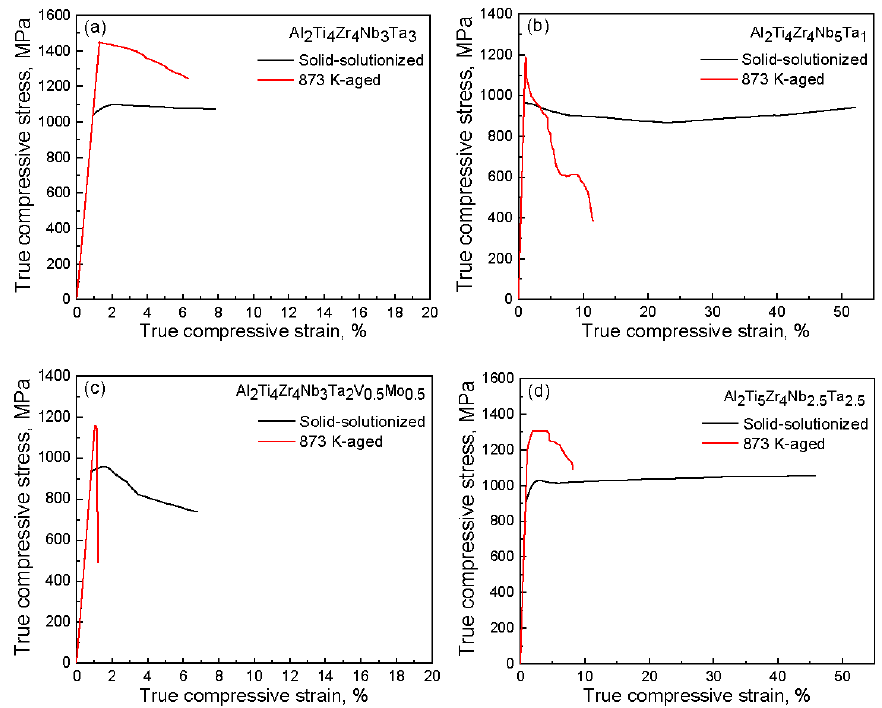
Figure 6. True compressive stress—strain curves of RHEAs at solid-solutioned and 873 K-aged states. ( a – d ): S0, S1, S2 and S3, respectively.